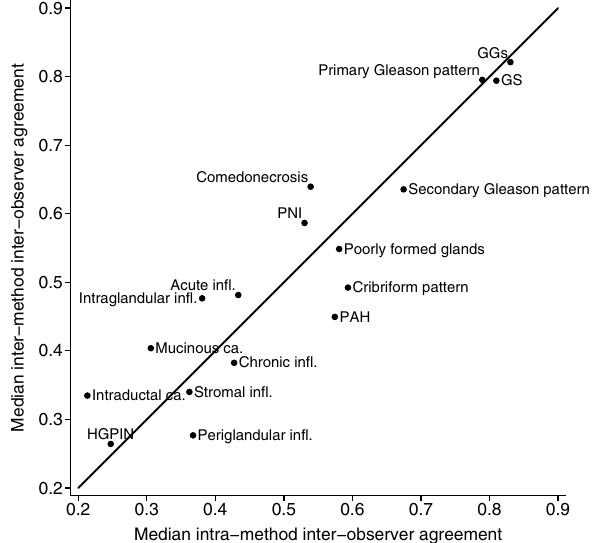
Figure 4. Interchangeability plot for all characteristics evaluated on the core and slide level. Note: Median intra-method inter-observer agreement refers to the median of the agreements between the Reviewer 1.1 vs. Reviewer 2 and Reviewer 1.2 vs. Reviewer 2 on LM and on VM. Median inter-method inter-observer agreement refers to the median of the agreements between the Reviewer 1.1 on LM vs. Reviewer 2 on VM, Reviewer 2 on LM vs. Reviewer 1.1 on VM, Reviewer 2 on LM vs. Reviewer 1.2 on VM and Reviewer 1.2 on LM vs. Reviewer 2 on VM. LM, light microscopy; VM virtual microscopy; GGs Gleason Grade Groups; GS Gleason score; PNI Perineural invasion; PAH Postatrophic hyperplasia; HGPIN High-grade prostatic intraepithelial neoplasia; infl Inflammation; ca